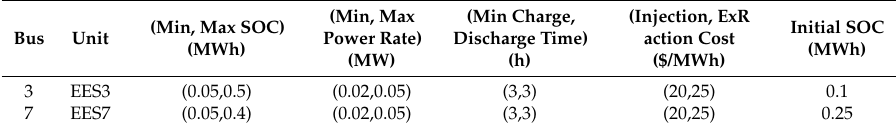
Table 1. Electrical energy storage (EES) unit parameters.